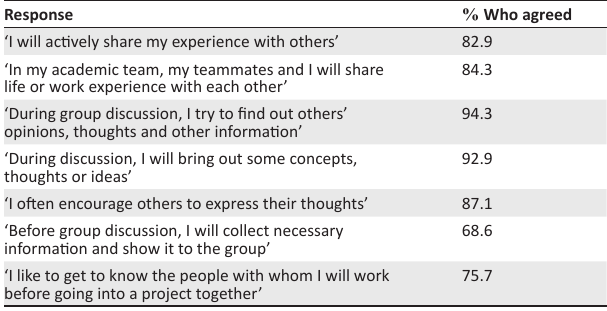
TABLE 1: Respondents’ use of socialisation.